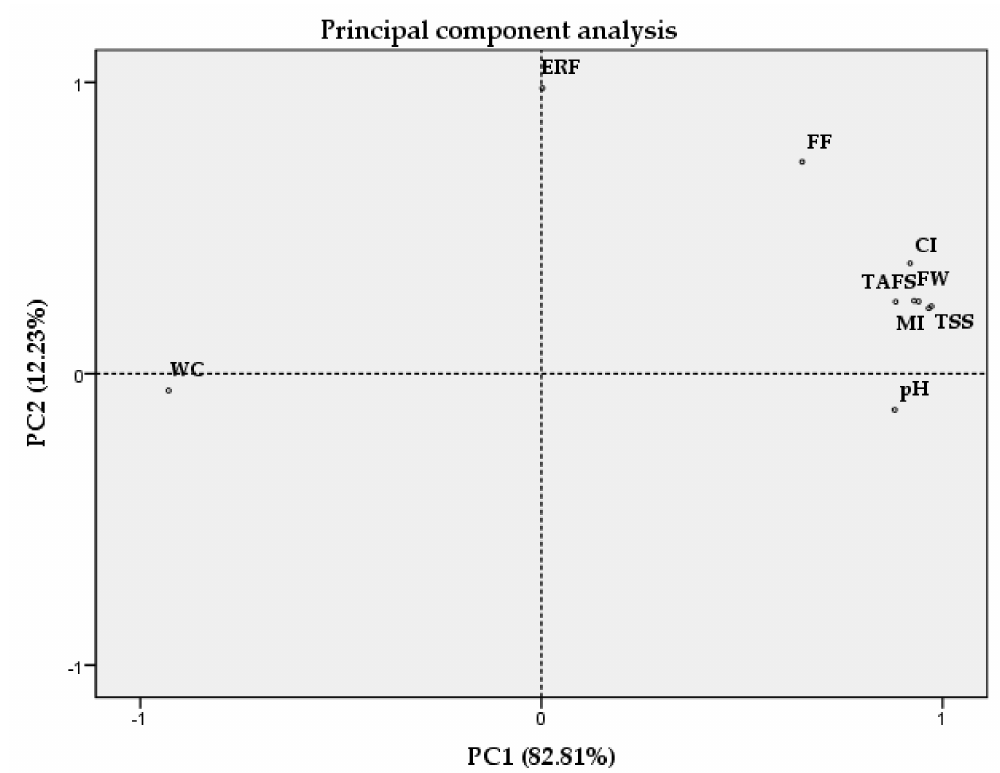
Figure 6. Principal component analysis using the whole dataset of two sweet cherry cultivars (Early Bigi and Lapins). Analyzed parameters: WC—wax content; ERF—epidermis rupture force;